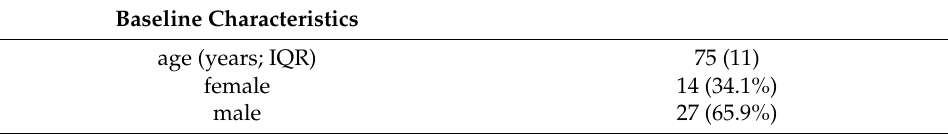
Table 1. Baseline characteristics of all